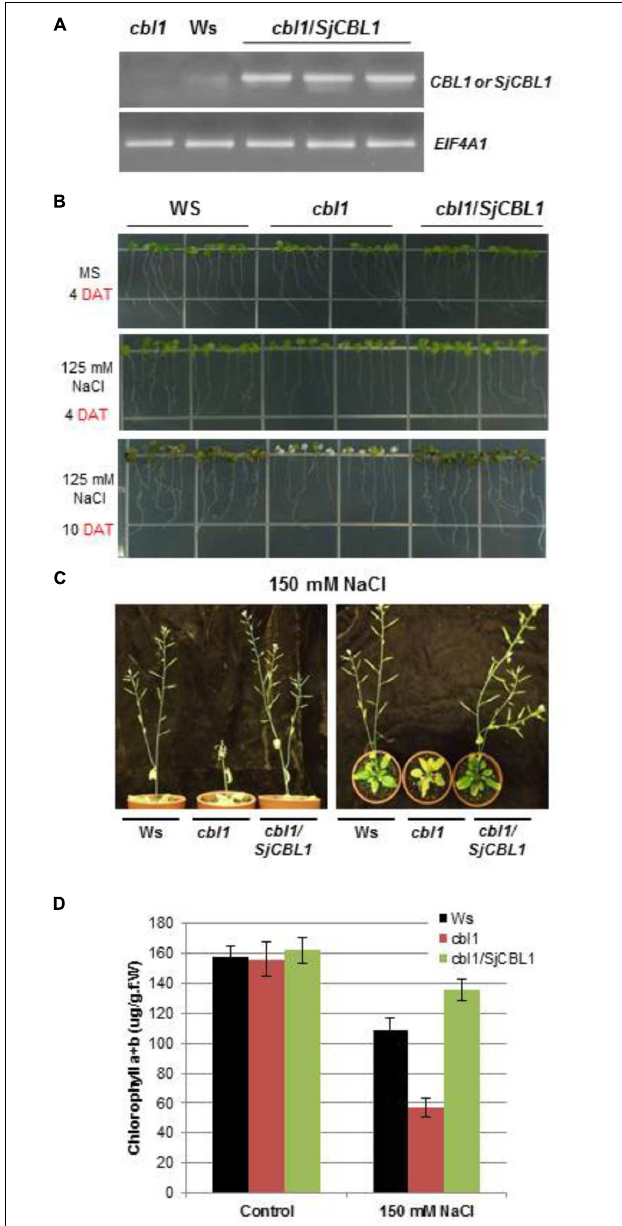
FIGURE 10 | Phenotype rescue in complemented (c bl1/SjCBL1 ) plants under salt stress. (A) Quantitative RT-PCR analysis of the CBL1 or SjCBL1 gene expression in wild-type (Wassilewskija [Ws]), cbl1 mutant, and complemented (c bl1/SjCBL1 ) plants. Total RNAs were isolated from 3-week-old plants and either CBL1-or SjCBL1-specific primers (top gel) were used for PCR amplification. Arabidopsis EIF4A1 gene (AT3G13920) was used as an internal control for transcript normalization (bottom gel). (B) Vertical growth assay. Seedlings at 4 days after germination were transferred to MS agar media supplemented with or without 125 mM NaCl, which were then placed vertically in the growth chamber. The pictures were taken on the 4th and 10th days after transfer (DAT). (C) Salt stress tolerance of the mature cbl1/SjCBL1 plants. Three-week old plants were exposed to 150 mM NaCl solution every 3 days for four repetitions. The pictures were taken on the 12th day after treatment from the side (left panel) and top (right panel). (D) Chlorophyll content of the plants from the experiment described in (C)